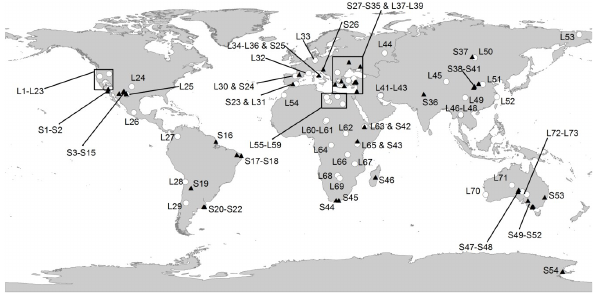
Fig. 1. The location of the soils and lake data used in this study to Figure 1. The location of the soils and lake data used in this study to reconstruct global Late 823 reconstruct global late Pliocene land surface features. Soil data have Pliocene land surface features. Soils data has the prefix S (Supplementary table 1), whilst 824 the prefix S (Supplement Table S1), whilst lake data have the prefix lakes data has the prefix L (Supplementary table 2). 825 L (Supplement Table